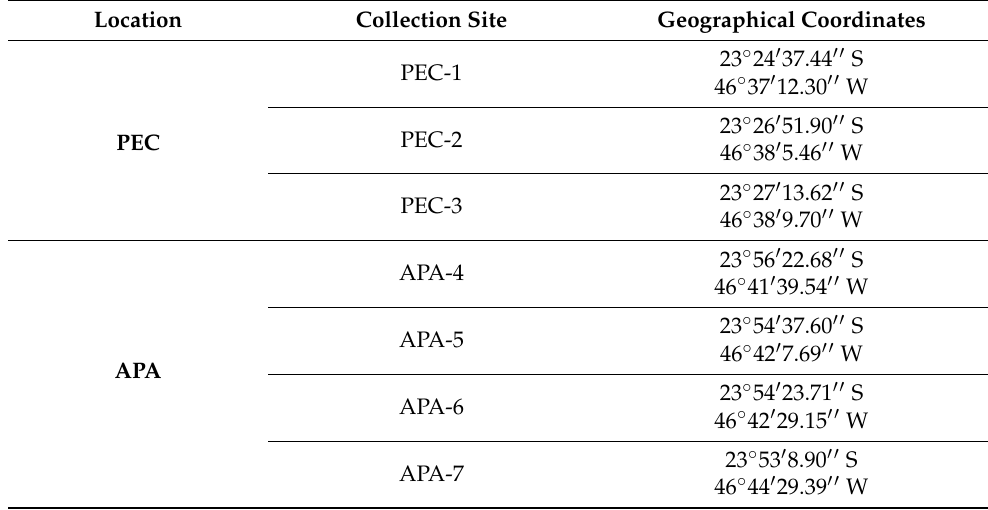
Table 1. Location of collection sites and aquatic habitats in which immature mosquitoes were found. Location Collection Site Geographical